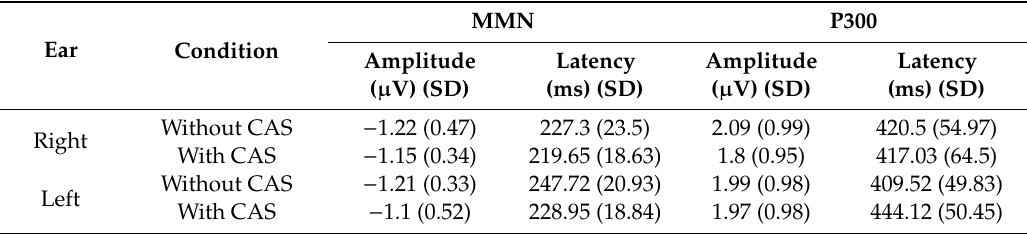
Table 6. Results of repeated-measures ANOVA for P300 peak amplitude and peak latency. Main E ff ects and